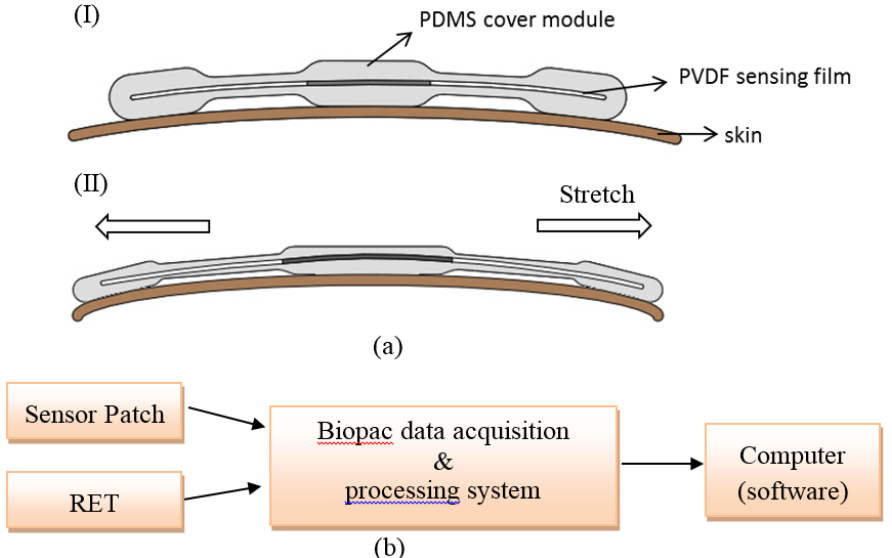
Figure 2. ( a ) Schematic illustration of the working mechanism of sensor patch: (I) the rest state; (II) the mechanical stretch of sensor patch due to the deformations on the chest wall of human body during the physiological movements of respirations; ( b ) the illustration of overall experimental